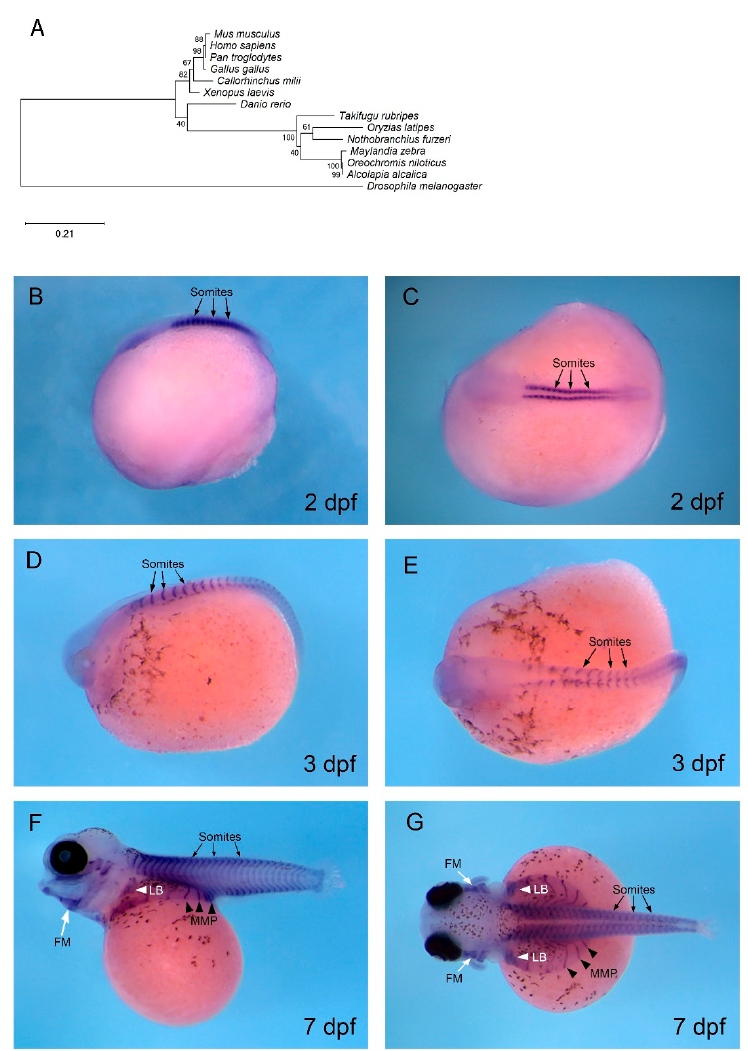
Figure 4. mef2c is expressed in developing muscle in O. alcalica . ( A ) Phylogenetic analysis of Mef2c. The evolutionary history was inferred by the maximum likelihood method and Jones with frequency model [64]. ( B – G ) In situ hybridisation of O. alcalica mef2c at 2 days post fertilisation (dpf) ( B , C ), 3 dpf ( D , E ), and 7 dpf ( F , G ). At 2 dpf and 3 dpf, mef2c was expressed in the somites ( B – E ). At 7 dpf, mef2c was expressed in somites, limb buds (LB), migrating muscle precursors (MMP), and facial muscle (FM). Black arrows denote the somites, black arrowheads mark migrating muscle precursors (MMP), white arrows denote facial muscle (FM), and white arrowheads mark limb buds (LB). ( B , D , F ) Lateral views; anterior to the left. ( C , E , G ) Dorsal views; anterior to the left.